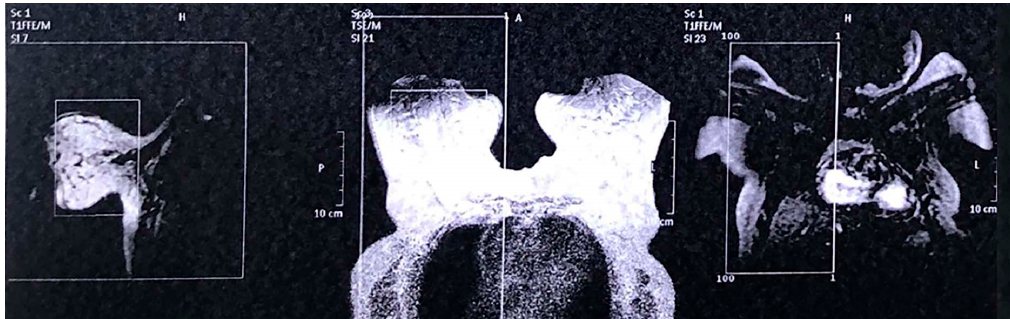
Figure 4. Magnetic Resonance Imaging of both breasts without conclusive findings.